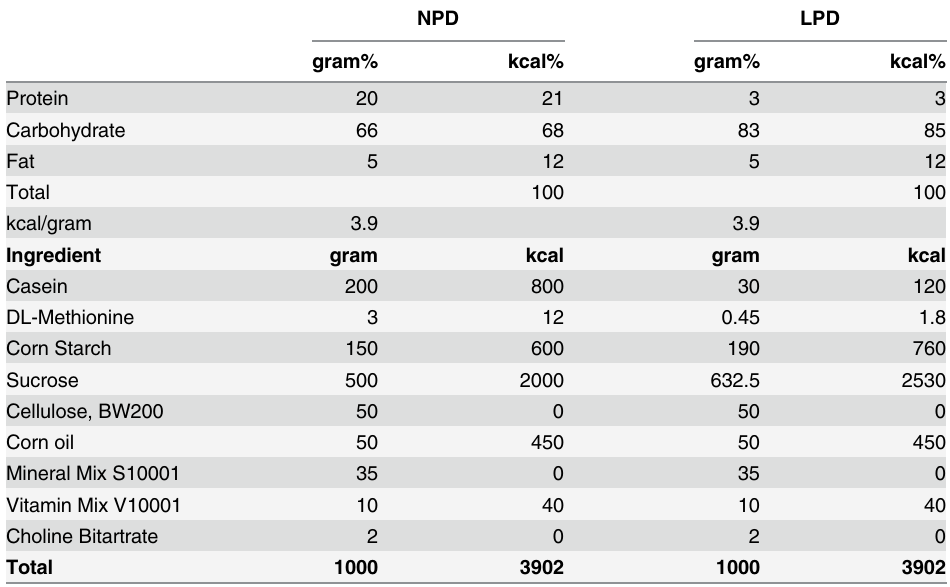
Table 1. Components of normal protein diet (NPD) and low protein diet